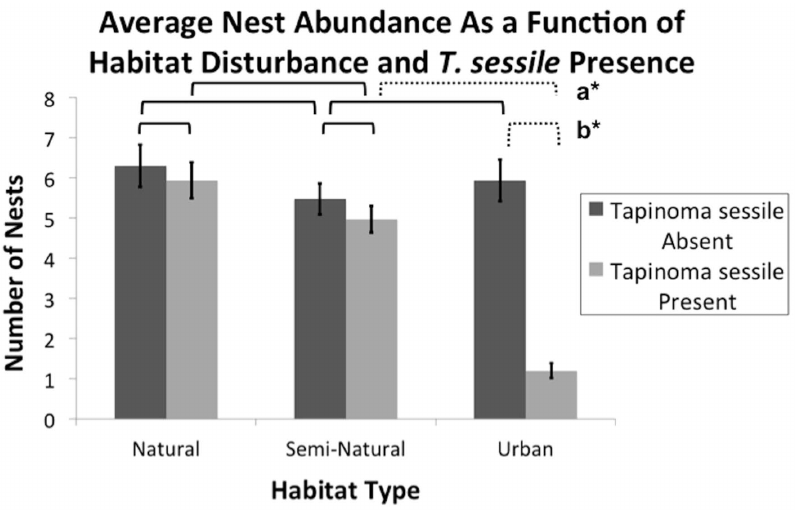
Fig. 2. Relative impacts of habitat alteration and Tapinoma sessile presence on average ant abundance. Bars at the column peaks indicate standard error. Brackets indicate an analysis of average nest abundance differences between columns under the bracket ends. Solid brackets denote non-significant difference of nest abundance. Dotted brackets followed by a bolded letter and asterisk denote significantly different nest abundance averages. Differences between average nest abundance were calculated using ANOVA testing under PROC GLIMMIX. a* : SE 5 0.21; df 5 87; Adj. P , 0.0001. b* : SE 5 0.22; df 5 87; Adj. P ,